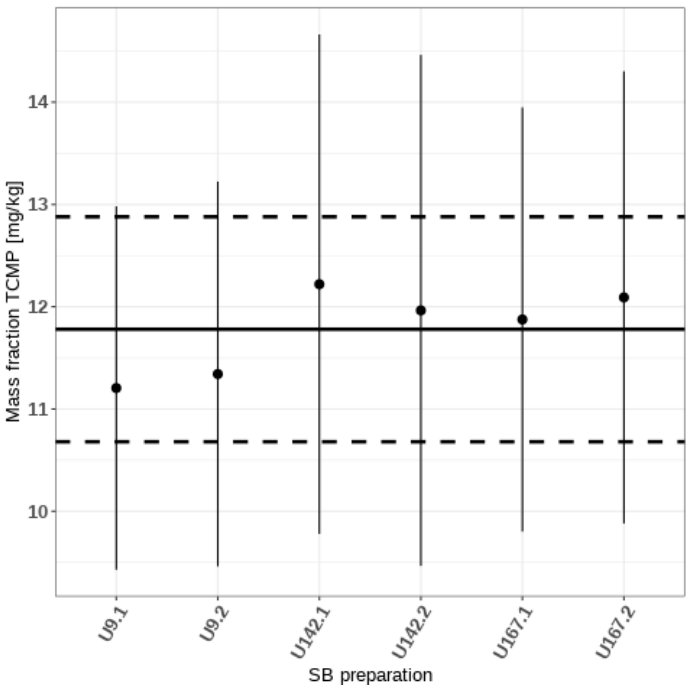
Figure 3. The mass fractions of TCMP in the six SB preparations with associated expanded measurement uncertainties. Solid circles depict the quantity values, and the vertical bars the uncertainties. The bold horizontal line represents the assigned value, and the dashed lines its uncertainty range .